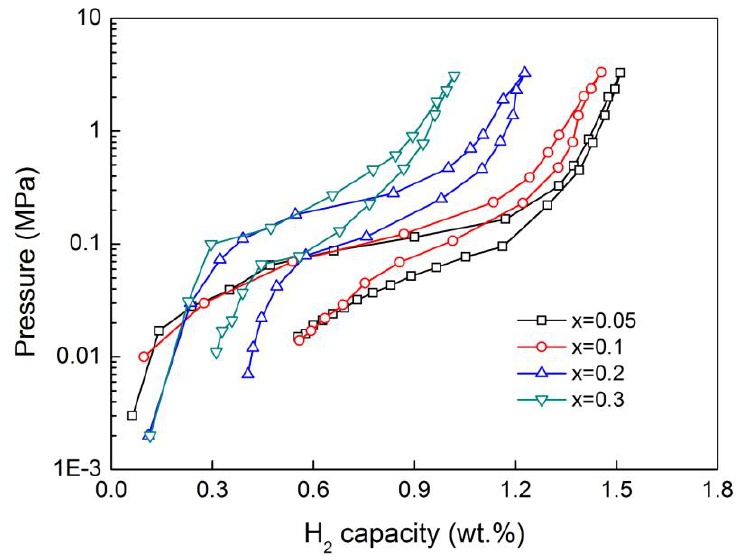
(Mg Zr )(Ni Co ) 0.7 0.3– x x 0.85 0.15 3.5